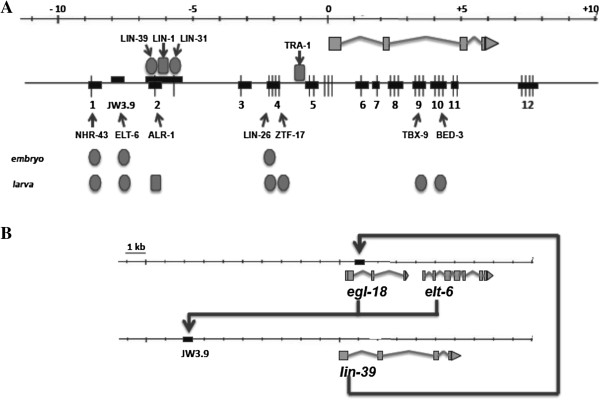
Direct transcriptional regulators of lin-39 in the embryo and larva. A) Horizontal lines represent 20 kb of genomic DNA surrounding the lin-39 locus. The lin-39 transcript is shown below the top line, with boxes representing exons. The next horizontal line shows evolutionarily-conserved regions (ECRs; thin vertical lines), the PCR fragments used in the yeast one hybrid assays containing the ECRs (boxes labeled 1–12), and two fragments (pJW3.9 shown, JW5 unlabeled) identified previously using an enhancerless GFP assay [47]. Transcription factors that bind the lin-39 gene are shown above the line (previously reported) or below the line (reported in this work). B) Model for positive feedback loop between egl-18/elt-6 and lin-39. EGL-18 and ELT-6 act via the GATA site in enhancer pJW3.9 to facilitate initiation of lin-39 expression in the embryo, and then LIN-39 acts to positively regulate egl-18/elt-6 expression via the Hox/Pbx binding site in the intron of egl-18[55].